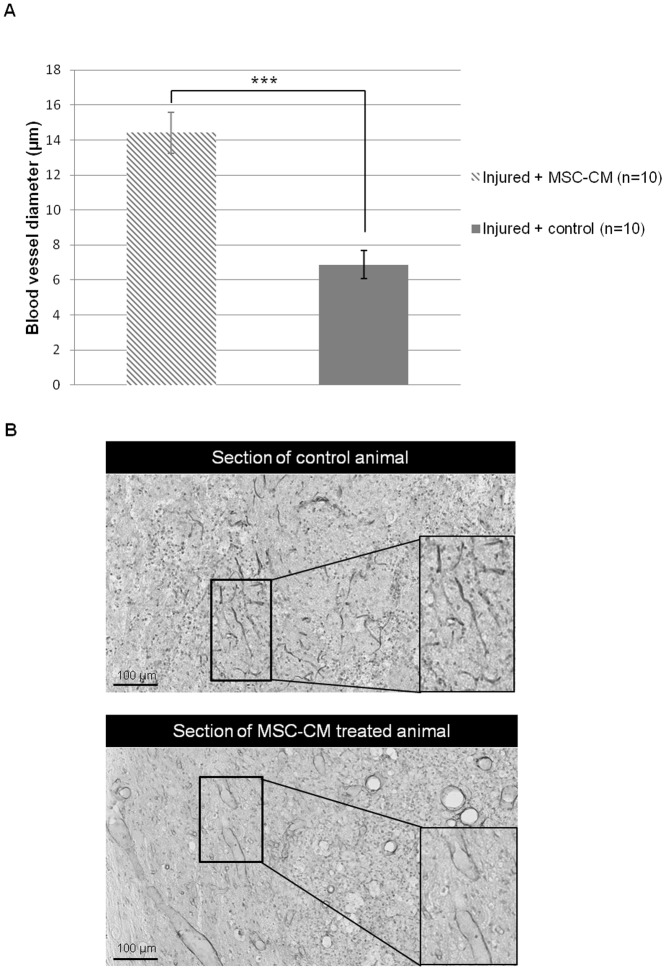
BMSC-CM increases blood vessel diameter within the lesion.(A) Mean blood vessel diameter at the lesion epicentre measured on RECA-1 immunostained sections from BMSC-CM and control groups 1 week after SCI, illustrated in (B). Blood vessels in BMSC-CM treated animals have larger diameters in comparison to control animals. 10 animals per group were studied. *** p<0.001.